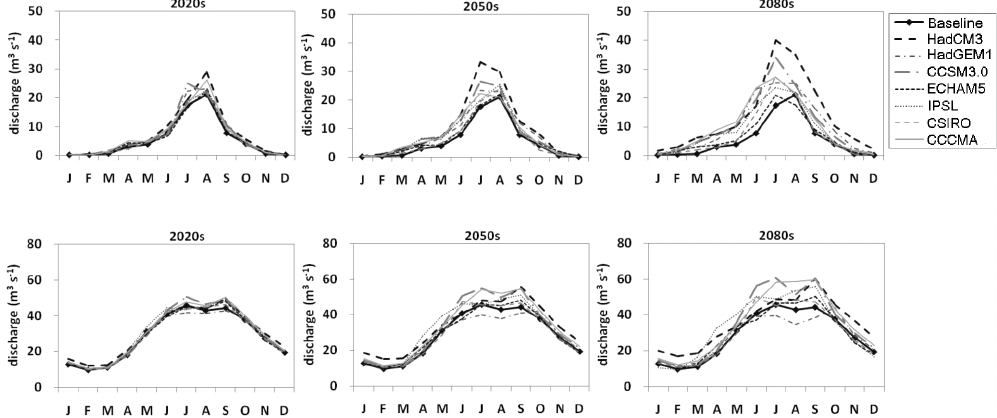
Figure 5. Average hydrographs for seven GCM projections for the 2020s, 2050s and 2080s time horizons and the 1961–1990 baseline for the rivers Huangfuchuan (top) and Xiangxi (bottom).